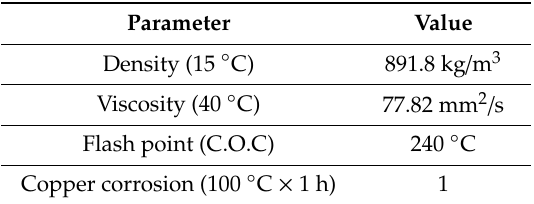
Figure 1. Geometry of the specimen used for the experiment: ( a ) image; ( b ) dimension (unit: mm). Table 2. Properties of the lubricant “Sunform